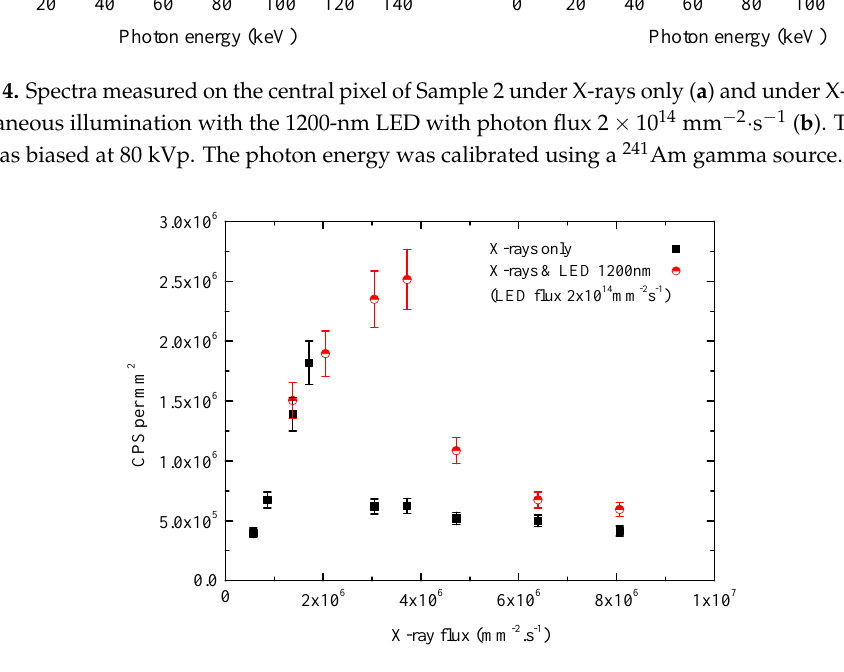
Figure 5. Sample 2: dependence of counts per second per mm 2 on X-ray